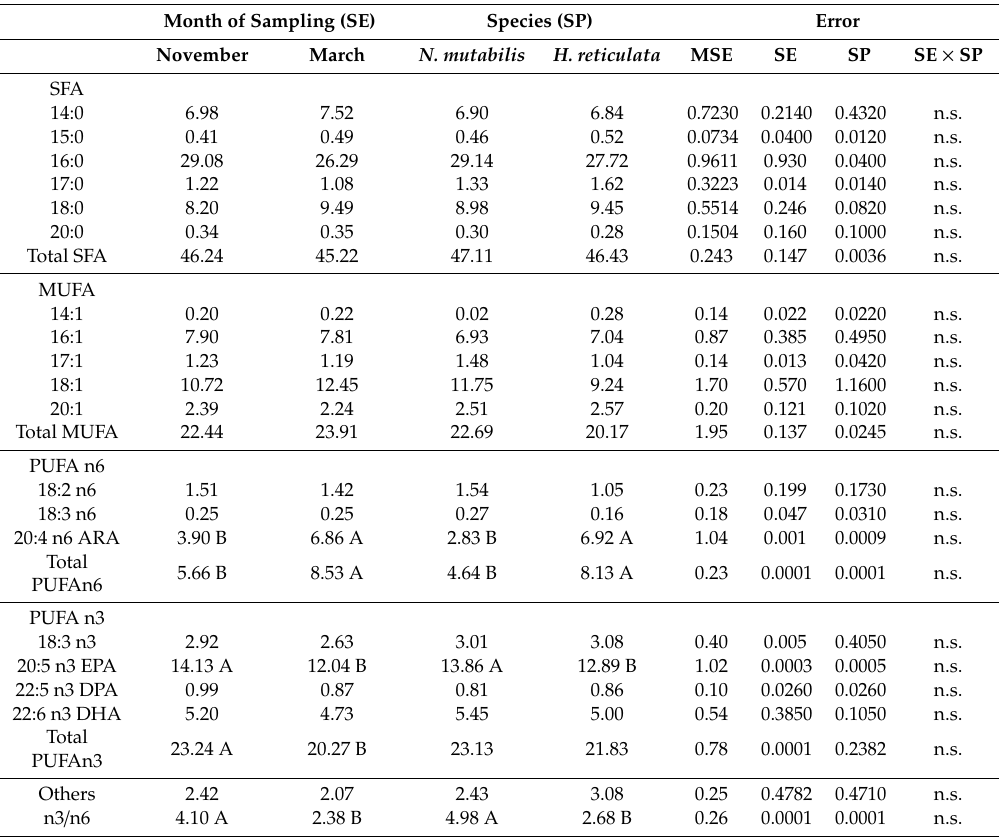
Table 3. Fatty acid profile (% total fatty acids) of the two species of sea snails according to season of sampling (SE) and species (SP).